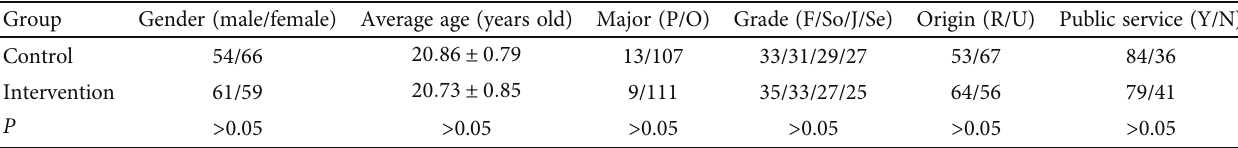
Table 1: General information of college students with excessive anxiety in the control and intervention groups from a comprehensive university in Taiyuan City, Shanxi Province, in Central China. Note: P: psychology or its related majors; O: other majors; F: freshmen; So: sophomores; J: juniors; Se: seniors; R: rural family; U: urban family; Y: yes; N: